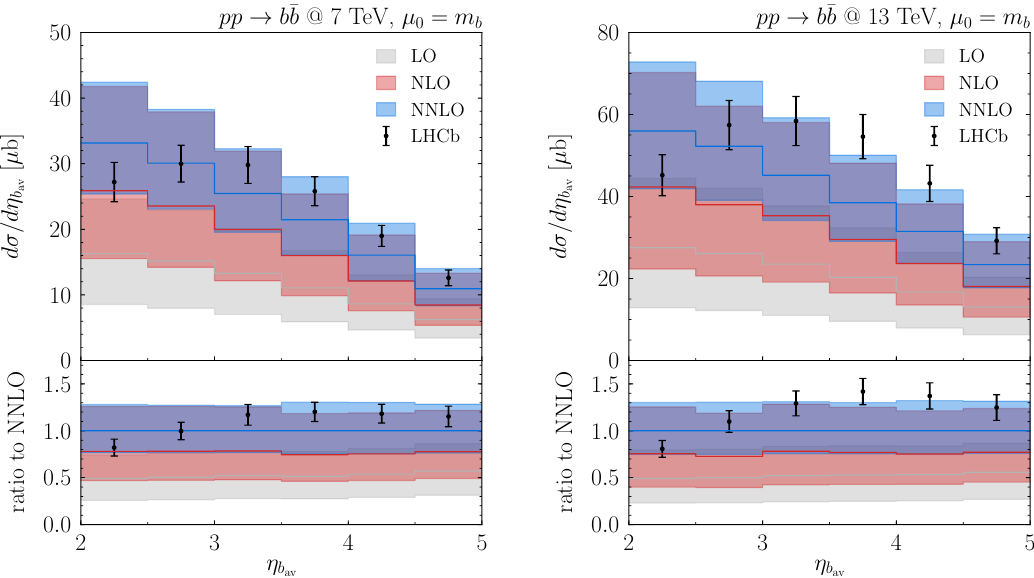
Figure 10 . Pseudorapidity distribution at the LHC for the scale choice (cid:22) 0 = m b , for centre of mass energy p s = 7 TeV (left) and 13 TeV (central). The lower panels show the ratio to the NNLO predictions. The theoretical predictions are compared with the LHCb data of ref.